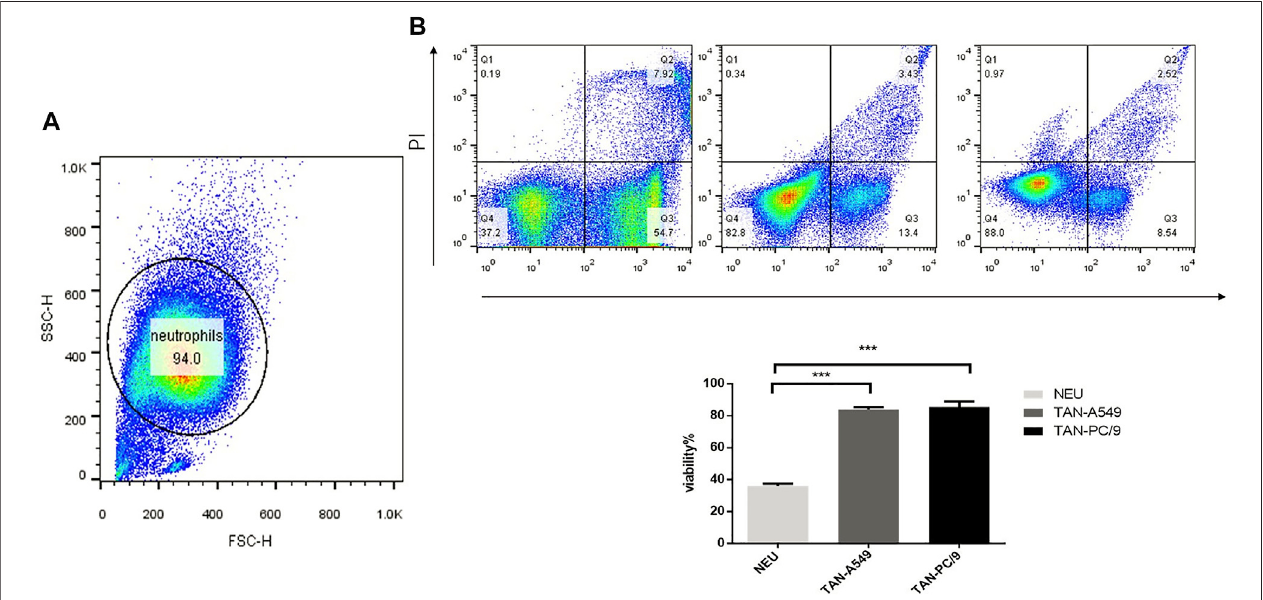
FIGURE2| Supernatantofcultured lungadenocarcinomacellsprolongedthelifespan ofneutrophils. (A) Thepurityofneutrophilswasanalyzedby fl owcytometry. (B) The viability of neutrophils, neutrophils treated with the supernatant of cultured lung adenocarcinoma cells PC-9 and A549 respectively, was veri fi ed using fl ow